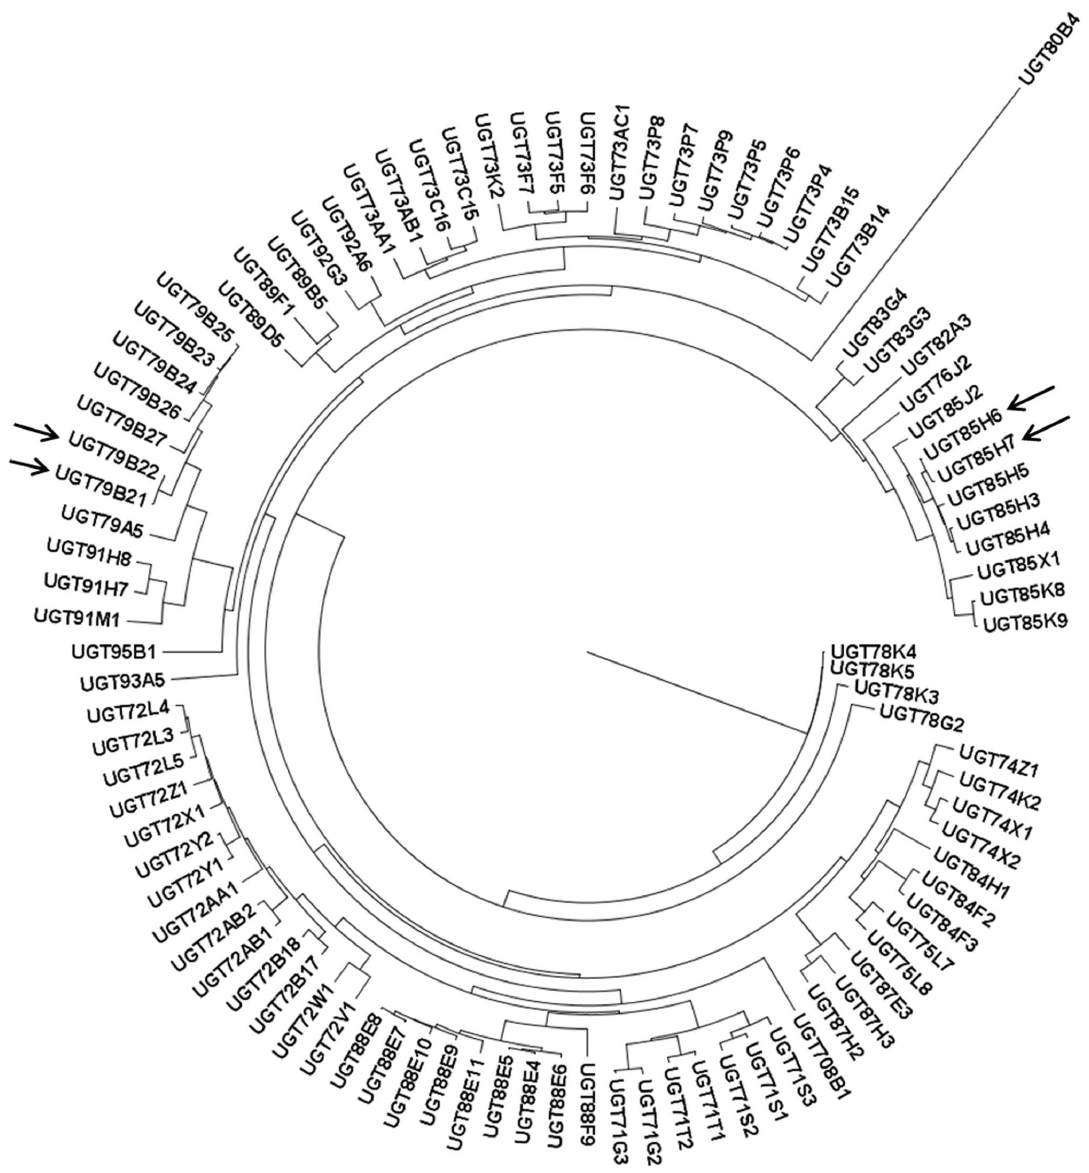
Figure 3. Phylogenetic analysis of Ca UGTs. Dendrogram showing clustering of 96 Ca UGTs along with two recent gene duplication events marked by